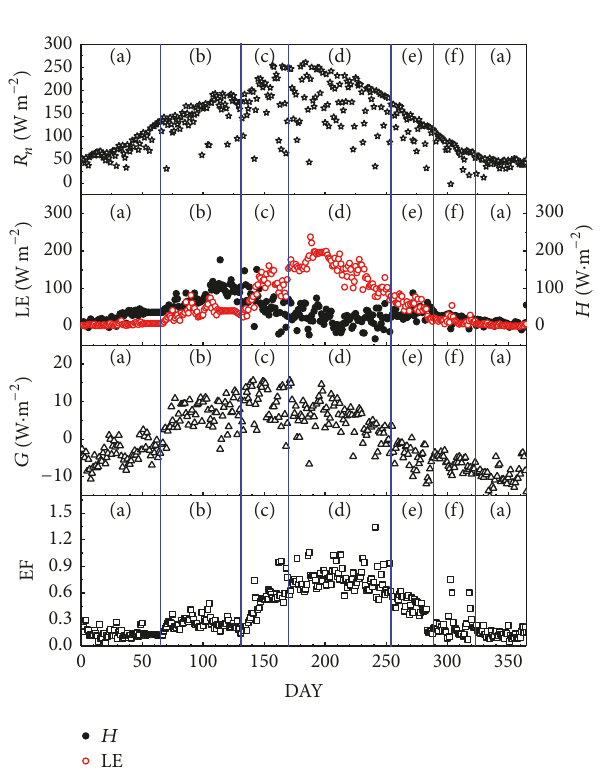
Figure 4: The annual course of daily average net radiation ( 𝑅 𝑛 ), latent (LE), sensible ( 𝐻 ), and soil heat fluxes, and the evaporative fraction (EF). (a) to (f) represent six periods: (a) the soil-frozen period; (b) the soil ablation period; (c) the germination, flowering, and leaf expansion period; (d) the vibrant growing season; (e) the leaf senescence period; and (f) the early soil-frozen period.